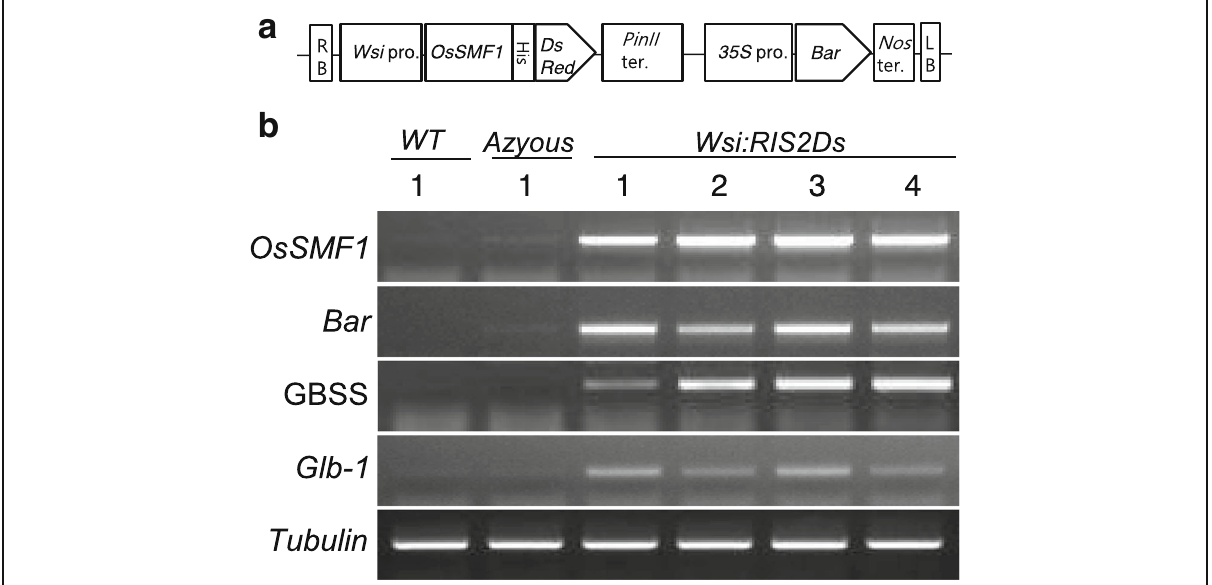
Fig. 4 Production of DsRed-fused OsSMF1-transformed rice. a Schematic representation of the expression vector Wsi:SMF1 used for rice transformation. Wsi pro, rice responsive to ABA protein promoter; PinII ter, potato proteinase inhibitor II terminator; 35S pro, cauliflower mosaic virus 35S promoter; Bar , phosphinothricin acetyltransferase; and Nos ter, nopaline synthesis terminator. b The expression of OsSMF1 and its target genes was determined by RT-PCR analysis. Specifically, the expression of granule-bound starch synthase (GBSS) and 26-kDa globulin ( α -Glb ) were analyzed. Total RNA was extracted from calli. Tubulin expression is shown as a constitutive